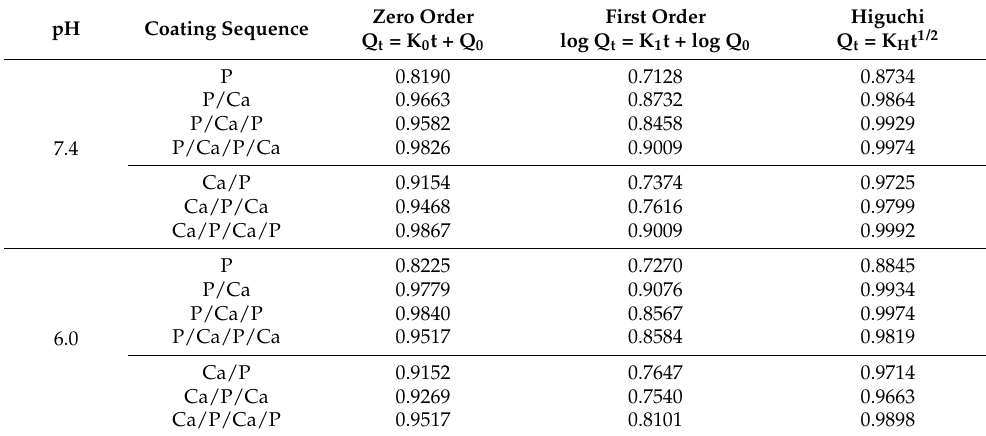
Table 3. Coefficients of determination obtained from linear regression analyses of various mathemati- cal